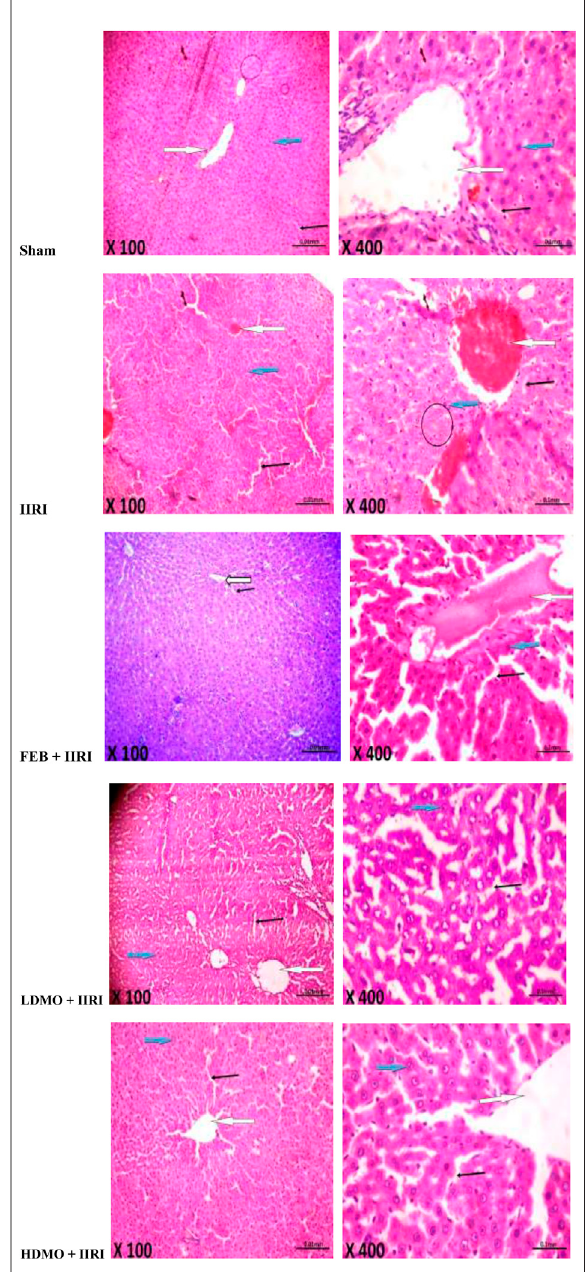
FIGURE 7 Effect of intestinal ischaemia/reperfusion (I/R) and methanolic Moringa oleifera leaf extract on hepatic histoarchitecture. The sham-operated rats showed preserved hepatic histoarchitecture with normal central venules (white arrow). The portal triads and hepatocytes appeared normal (blue arrow), and the sinusoids also appeared normal (slender arrow). The intestinal ischaemia/ reperfusion injury (IIRI) group showed moderately congested centralvenules(whitearrow)withnormalhepatocytes(bluearrow), mildly dilated sinusoids (slender arrow), and neutrophil in fi ltration (circle). The febuxostat (FEB) + IIRI rats showed mildly congested central venules (black arrow). However, the hepatocytes appeared normal (white arrow) and the sinusoids appeared mildly dilated (slender arrow). The low dose Moringa oleifera (LDMO) + IIRI ( Continued )